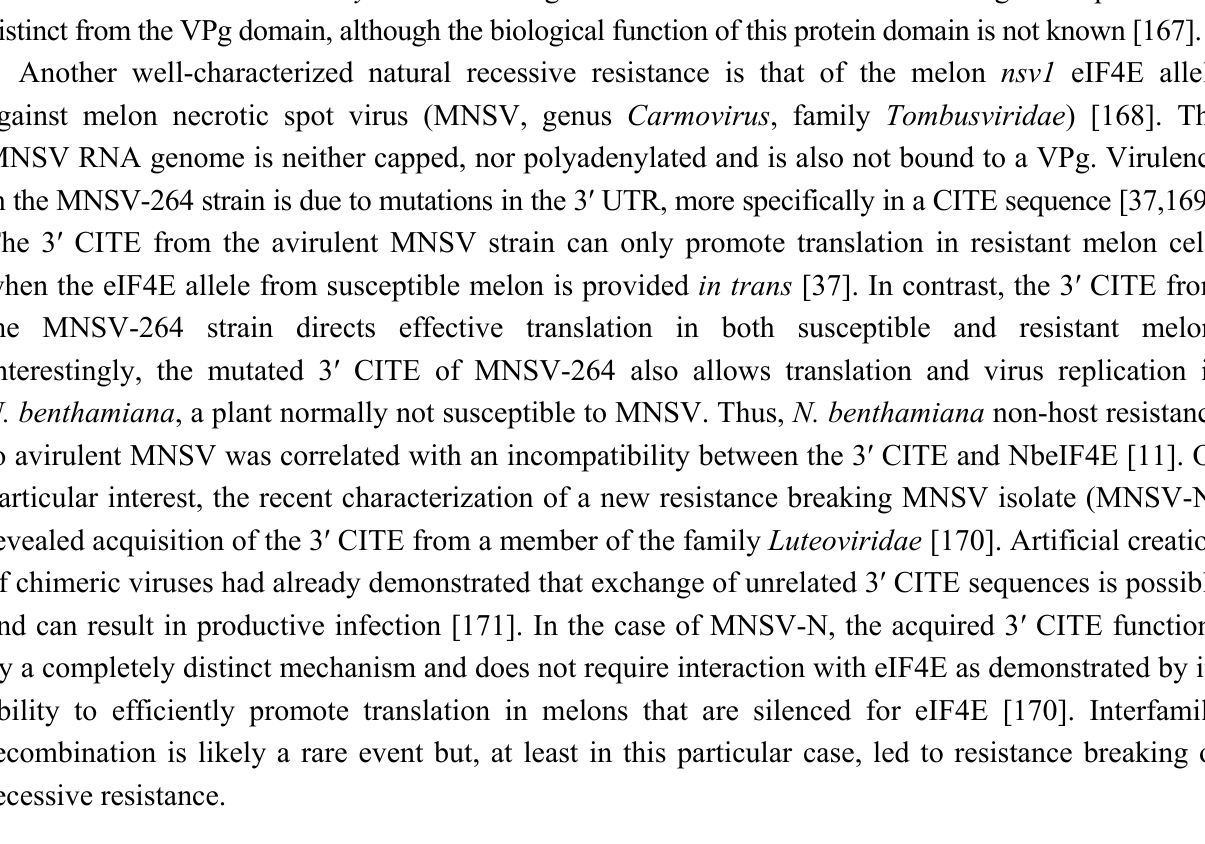
Table 2. Resistance to non-potyvirids based on isoforms of eIF4E or eIF4G.